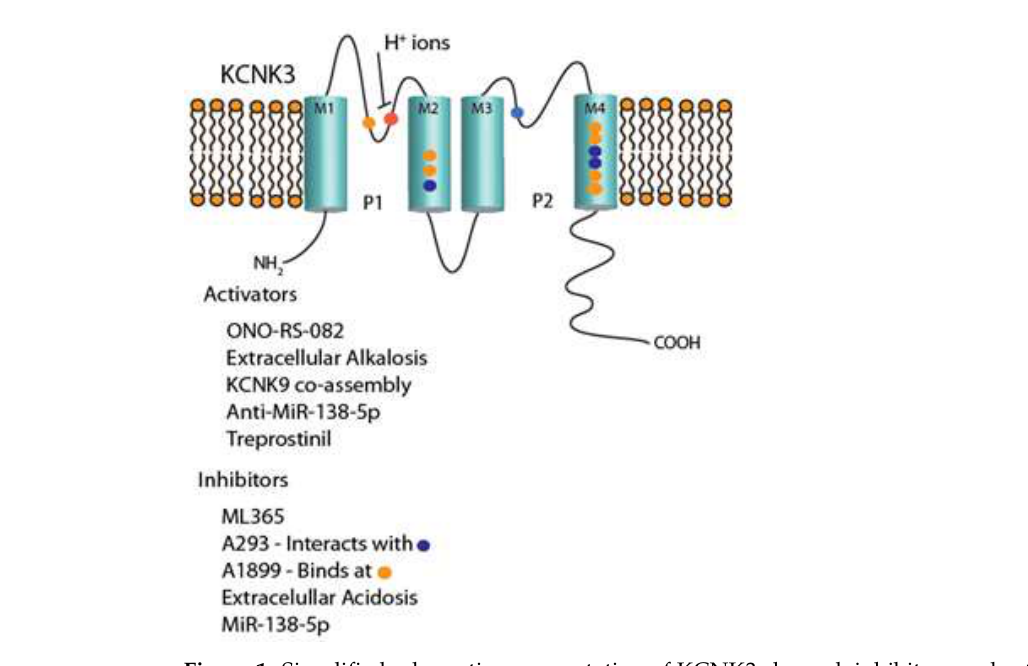
Figure 1. Simplified schematic representation of KCNK3 channel; inhibitors and activators of the channel listed with color-coded regulatory sites. M1–M4 = transmembrane segment number. P1 and P2 = pore domain number. Blue dot = amino acid interaction site of A293. Orange dot = amino acid interaction site of A1899.